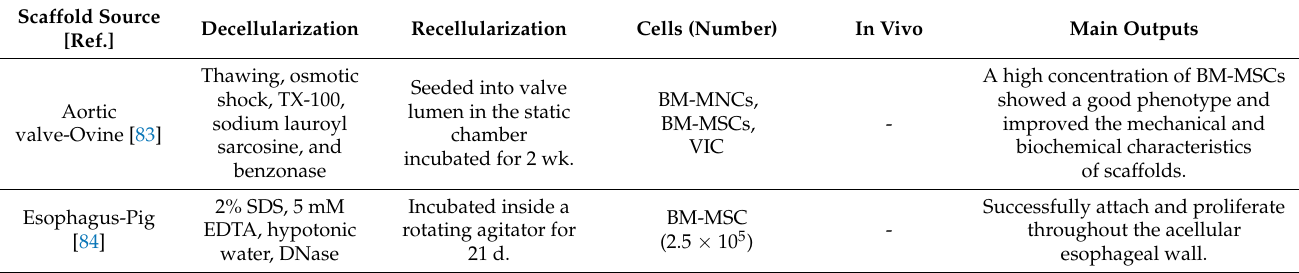
Table 1. The factors that could affect the success of the recellularization